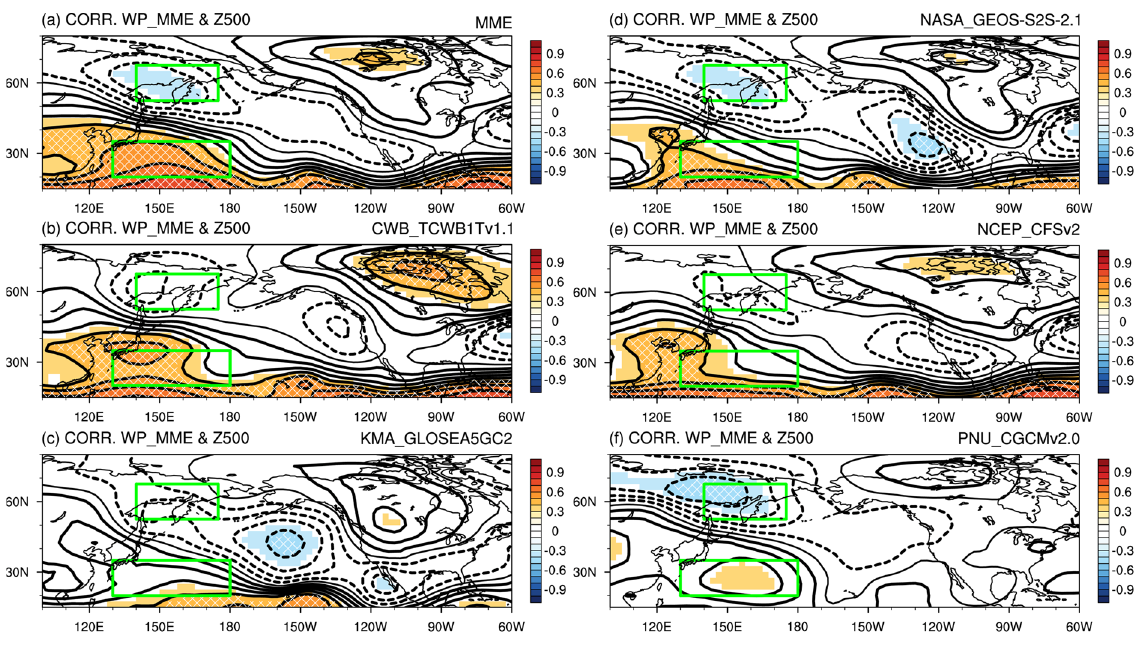
Figure 5. Correlation patterns between Z500 and the WP index predicted by the ( a ) MME and ( b – f ) individual models for the entire series without the SEN years. Green boxes enclose the areas of Z500 averaging used for the estimation of the WP index. Significant at the 99% (95%) confidence level values are shown by hatch pattern (shading).